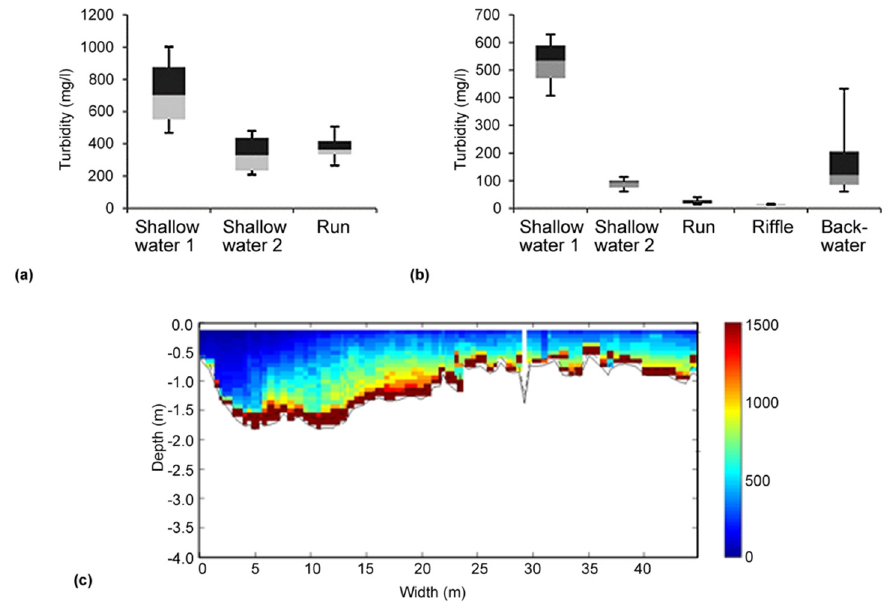
Figure 2. ( a + b ) Habitat-related variation in turbidity at two di ff erent sites and di ff erent dates during the controlled drawdown of the Gepatsch reservoir; measuring time at each habitat type: 10 min; box plots: di ff erent grey shadings represent 50% of the analyzed data; ( c ) Cross sectional plot of the ADCP-recorded turbidity (SSC in mg L − 1 ) at Prutz (04.02.2016).